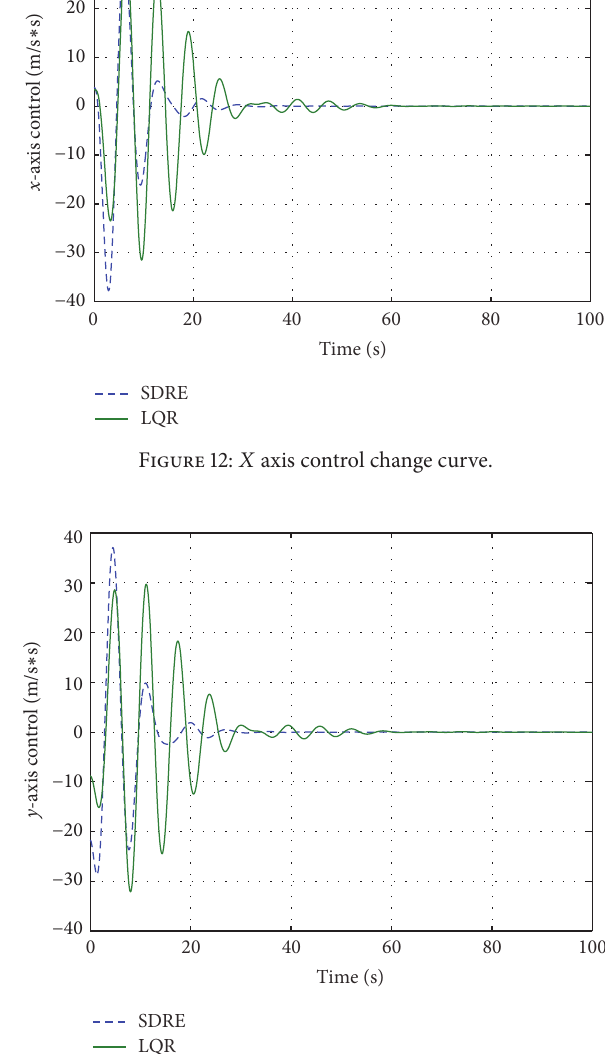
Figure 13: 𝑌 axis control change